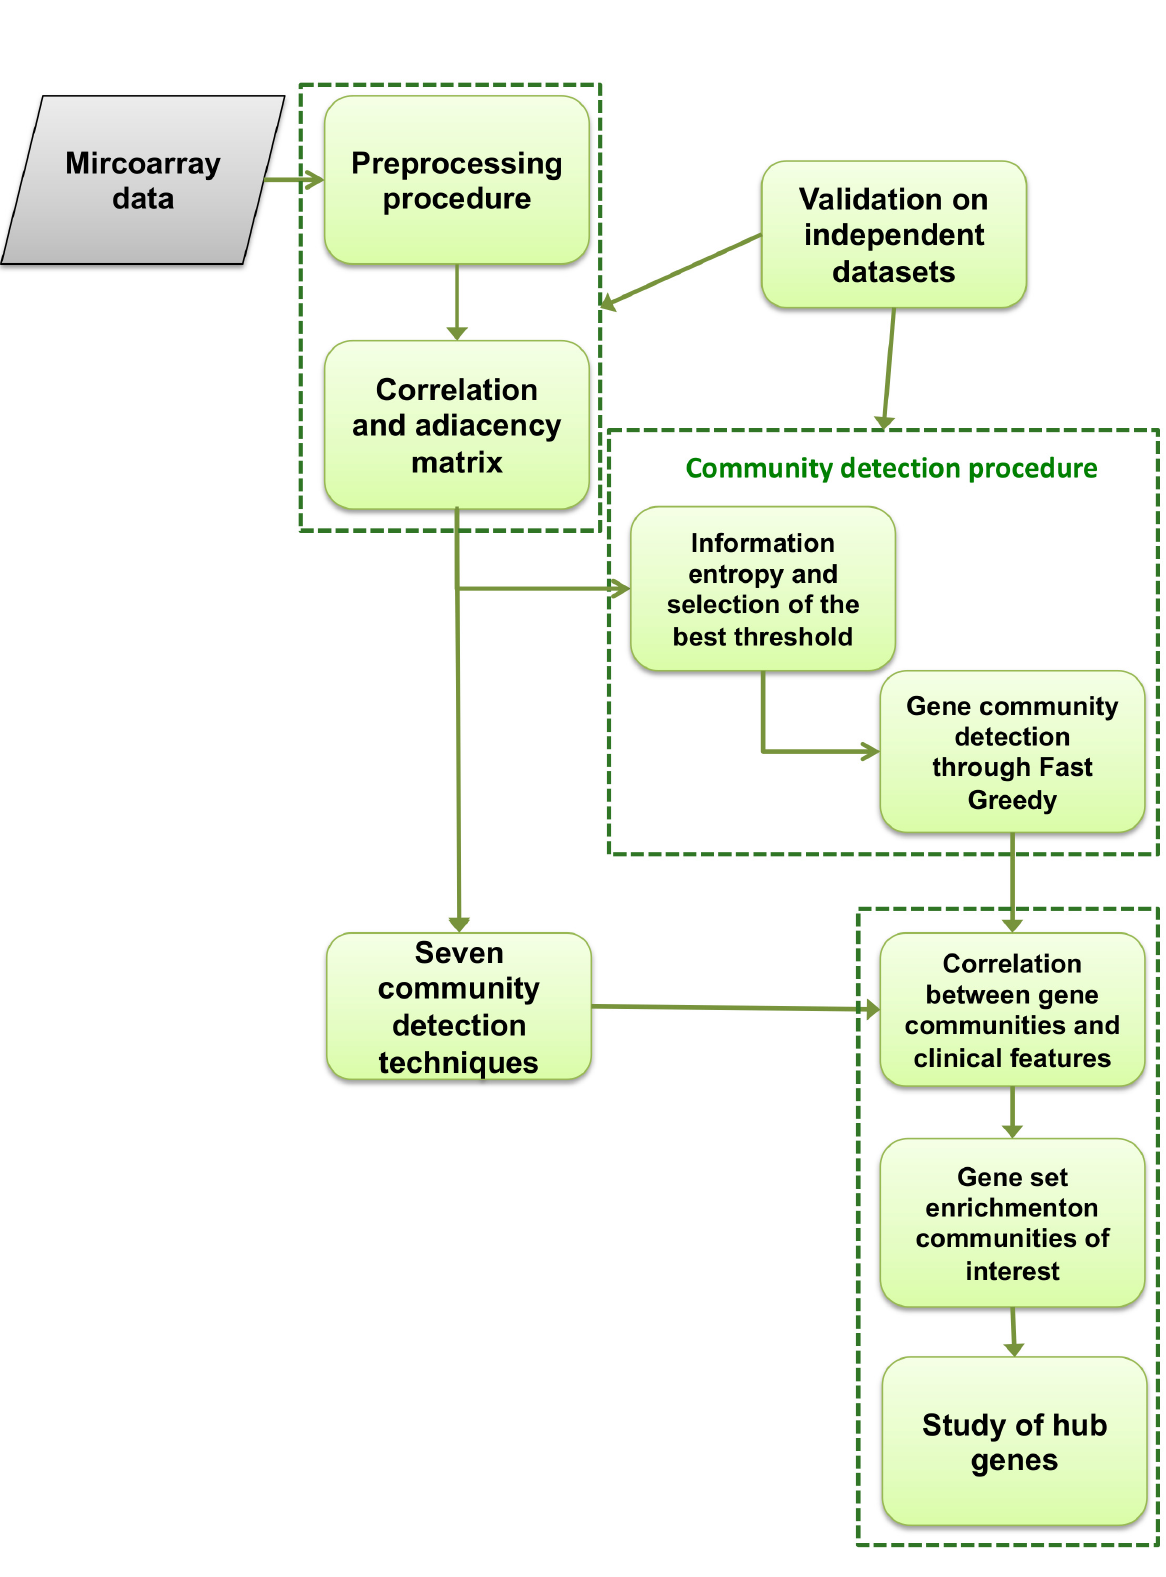
Fig 1. Flowchart of the methodology. After a preprocessing analysis, we implemented a community detection procedure based on hard threshold analysis and information theory proposed in a previous work [21]. We conduced a correlation analysis between gene communities and MMSE value